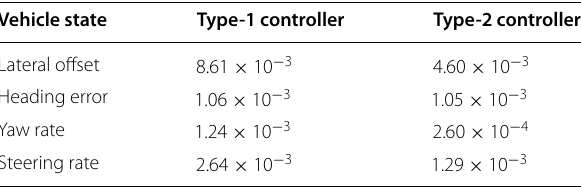
Table 2 Root mean square (RMS) of vehicle states responding to given road curvature